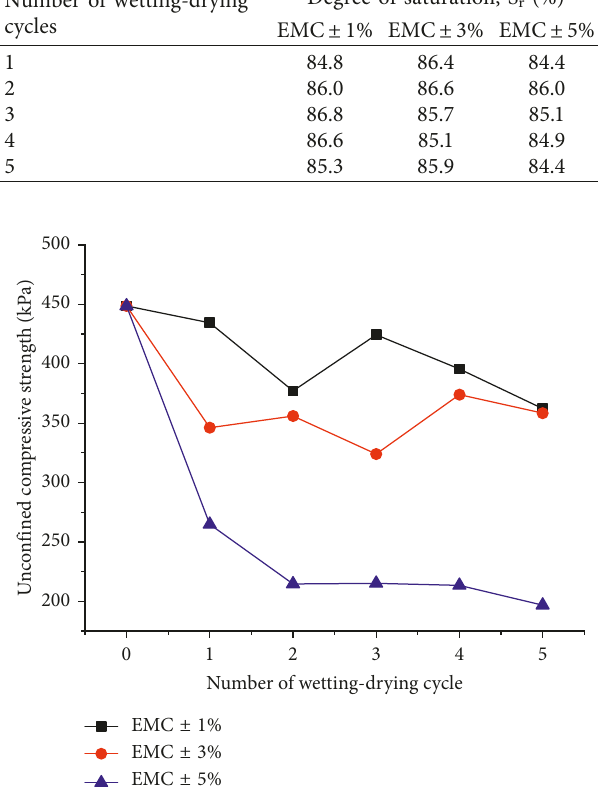
Figure 9: Effect of wetting-drying cycles on unconfined com- pressive strength of